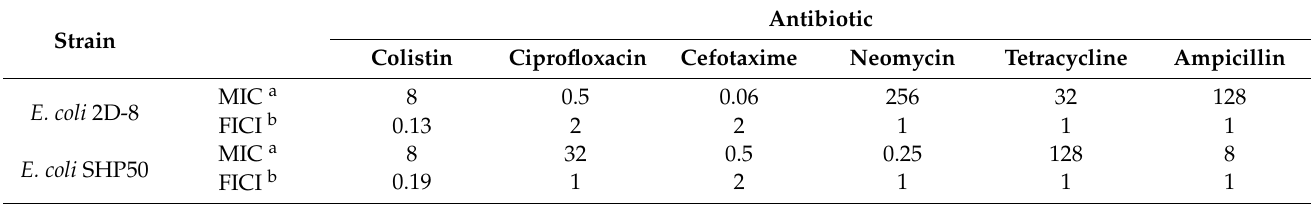
Table 2. MIC (mg/L) values of capric acid and various antibiotics and FICI values of capric